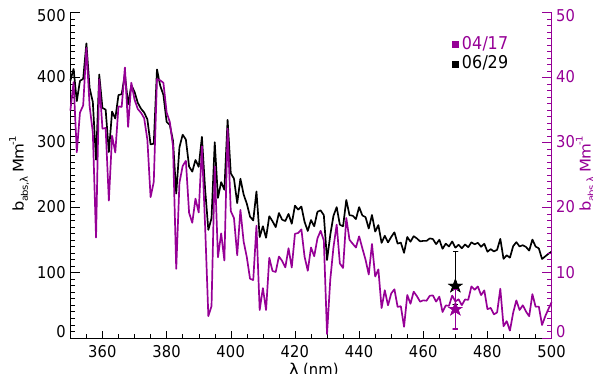
Fig. 5. Spectral b abs ,λ calculated from retrieved in-plume average SSA for 17 April (purple, right axis) and 29 June (black, left axis). Mean PSAP b abs , 470 for 17 April and 29 June are shown as a pur- ple and black star, respectively. Maximum and minimum b abs , 470 values measured for the plume are shown by error